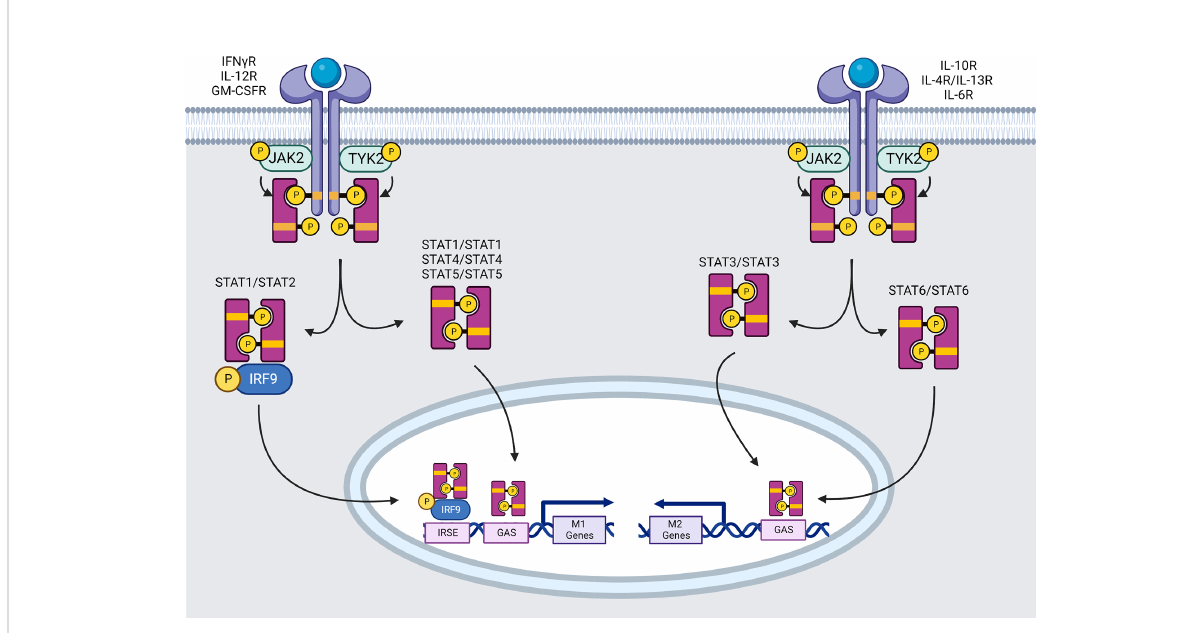
FIGURE 1 Signaling pathways mediated by the JAK family of tyrosine kinases (created using BioRender ®